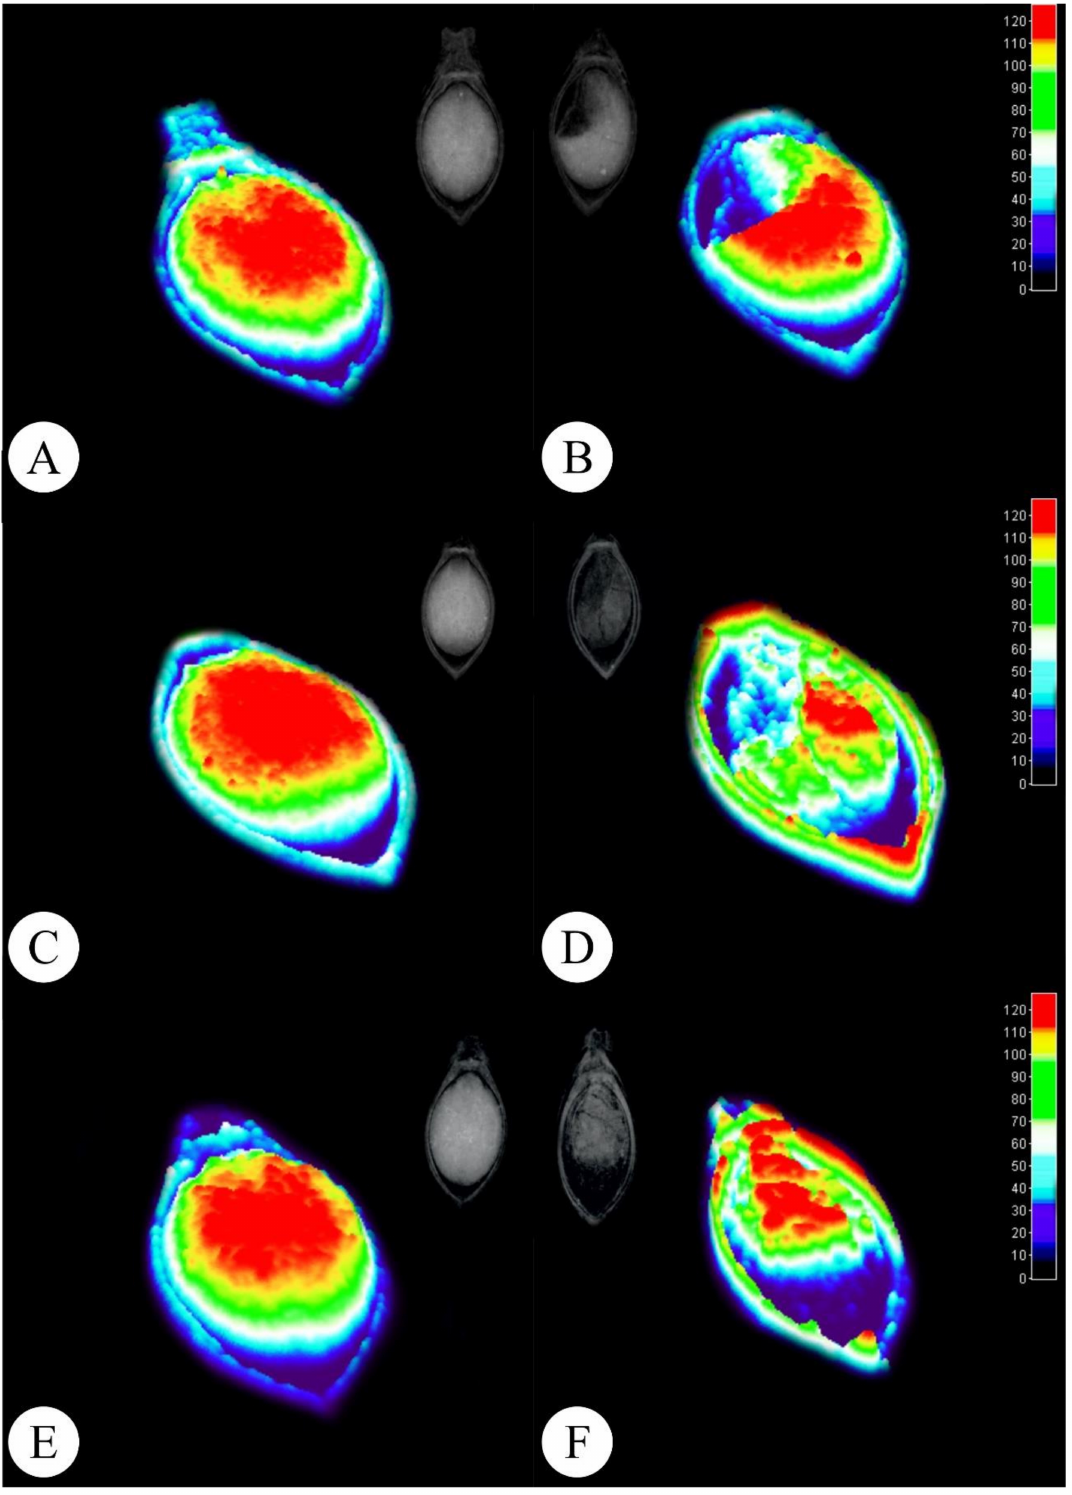
Figure 2. Radiographic Brachiaria brizantha seed images and their representations in 3D. ( A , B ) Marandu cv. ( C , D ) Piat ã cv. ( E , F ) Xara é s cv. Left column: higher tissue density seeds. Right column: lower tissue density